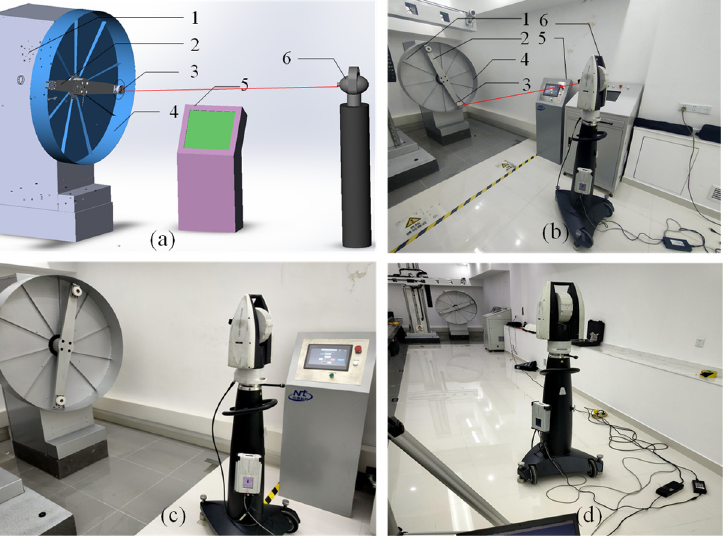
Figure 1. ( a ) The CAD simulation diagram of dynamic measurement: 1—Main body of circular trajectory generator (high-precision spindle motor, motor holder, transmission system), 2—Rotating arm, 3—Microsphere holder, 4—Protective cover, 5—Rotational velocity control system, 6—Laser tracker. ( b ) The actual measurement diagram of dynamic measurement: 1—Main body of circular trajectory generator (high-precision spindle motor, motor holder, transmission system), 2—Rotating arm, 3—Microsphere holder, 4—Protective cover, 5—Rotational velocity control system, 6—Laser tracker. ( c ) The measurement with the distance of 2 m and ( d ) the measurement with the distance of 10 m.